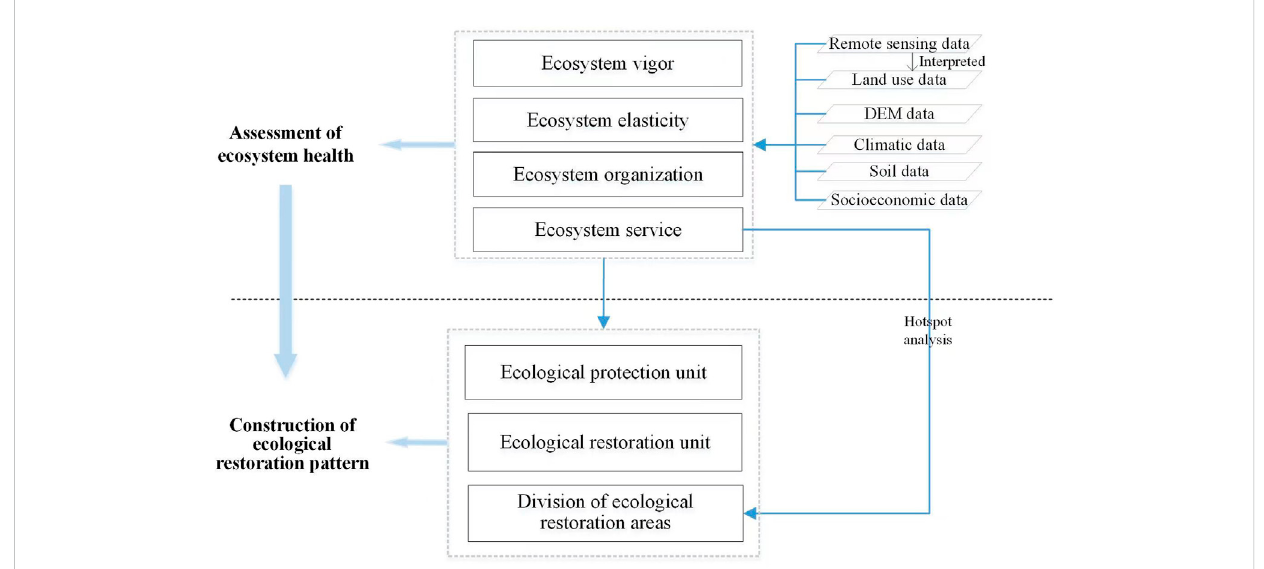
FIGURE 2 Flowchart for reconstructing the spatial pattern of ecological restoration.